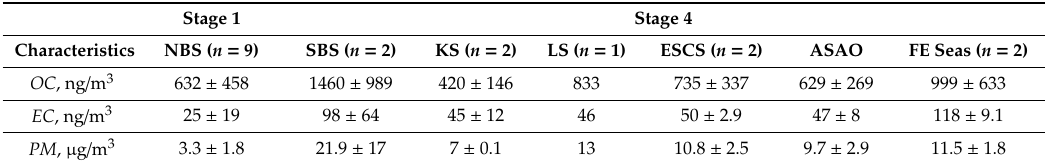
Table 5. Average ( ± SD) OC, EC, and PM concentrations in separate regions of the “TransArctic–2019” expedition ( n is the number of aerosol samples).